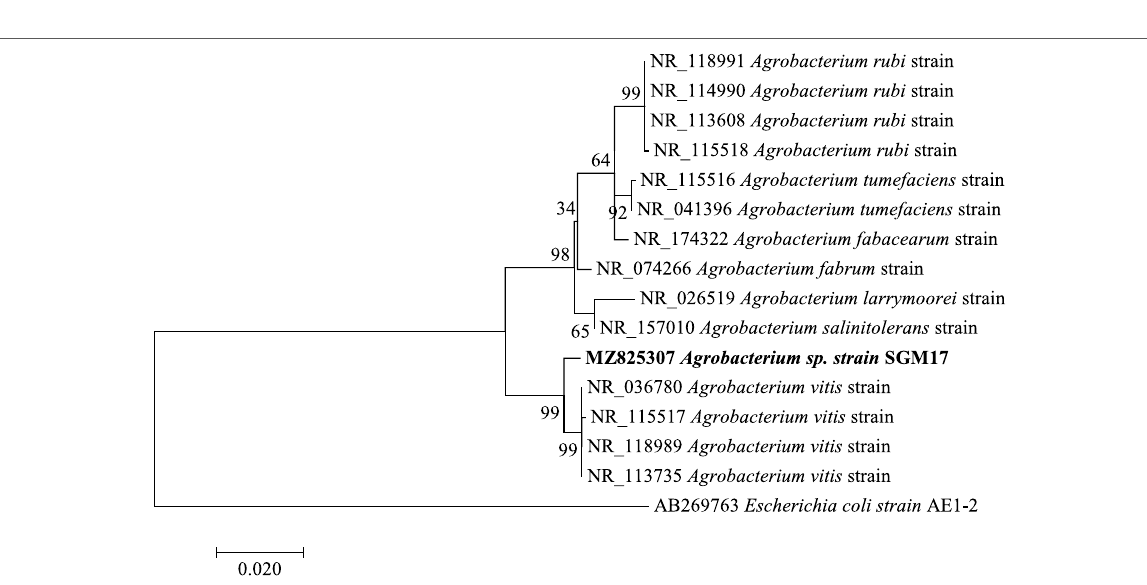
Fig. 5 Maximum likelihood phylogenetic tree based on analysis of partial 16S rRNA nucleotide sequence of Agrobacterium sp. strain SGM17 with reference sequences selected from the NCBI . Escherichia coli strain AE1-2 was used as an